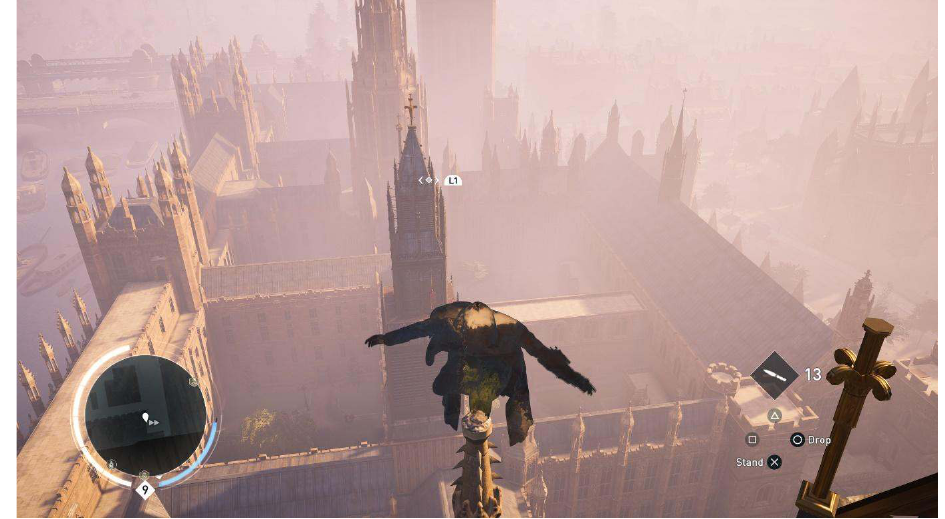
Figure 6: A look at the top of the Houses of Parliament from Big Ben